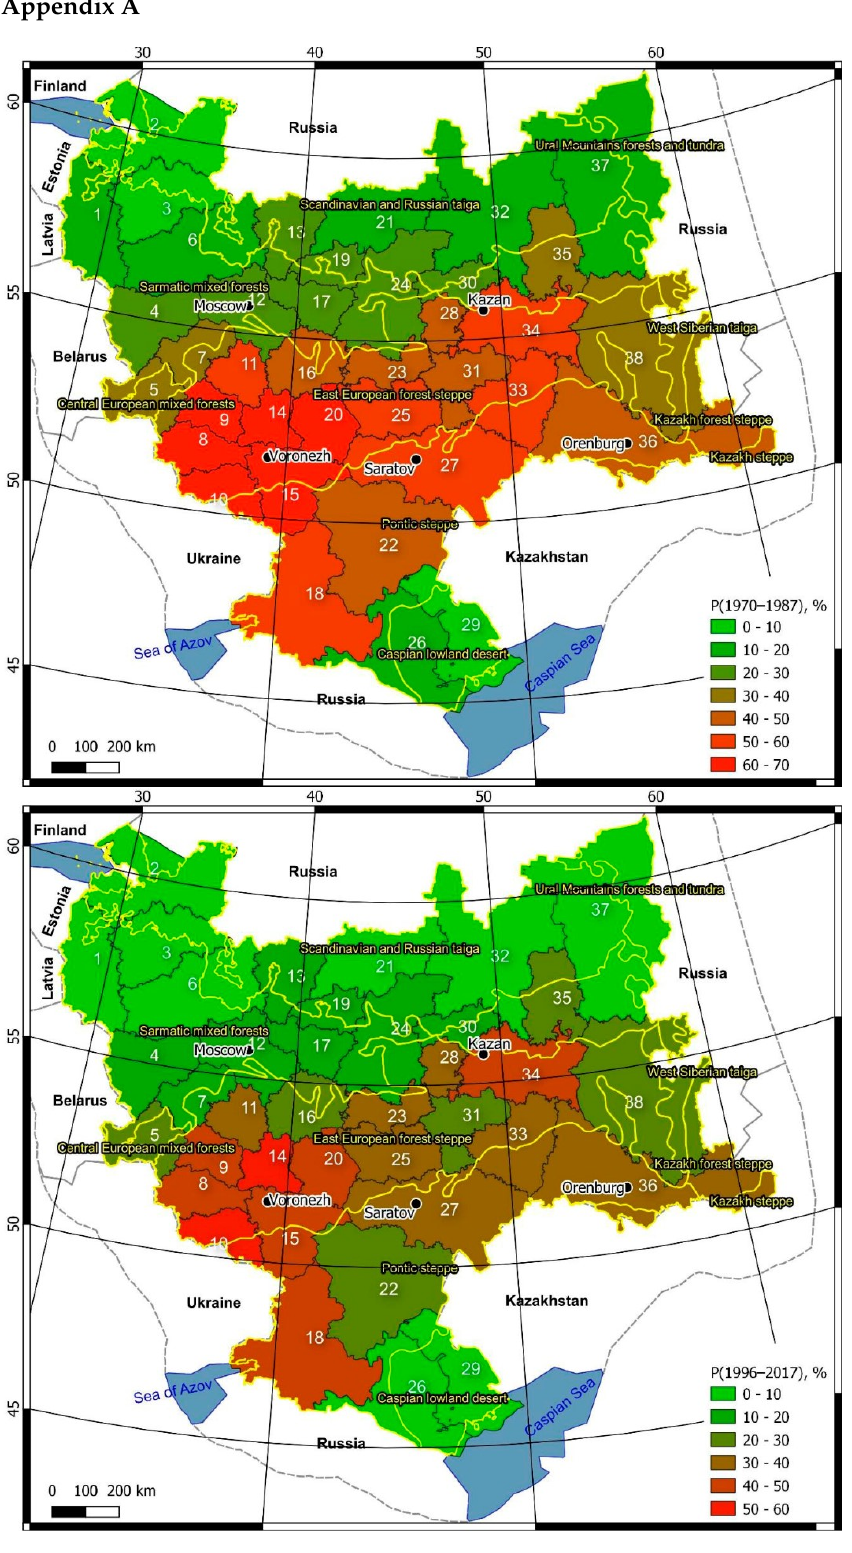
Figure A1. The portion (P) of cultivated land in the total area of the analyzed administrative regions of European Russia during 1970–1987 and 1996–2017. For other symbols, see Figures 2 and 3.